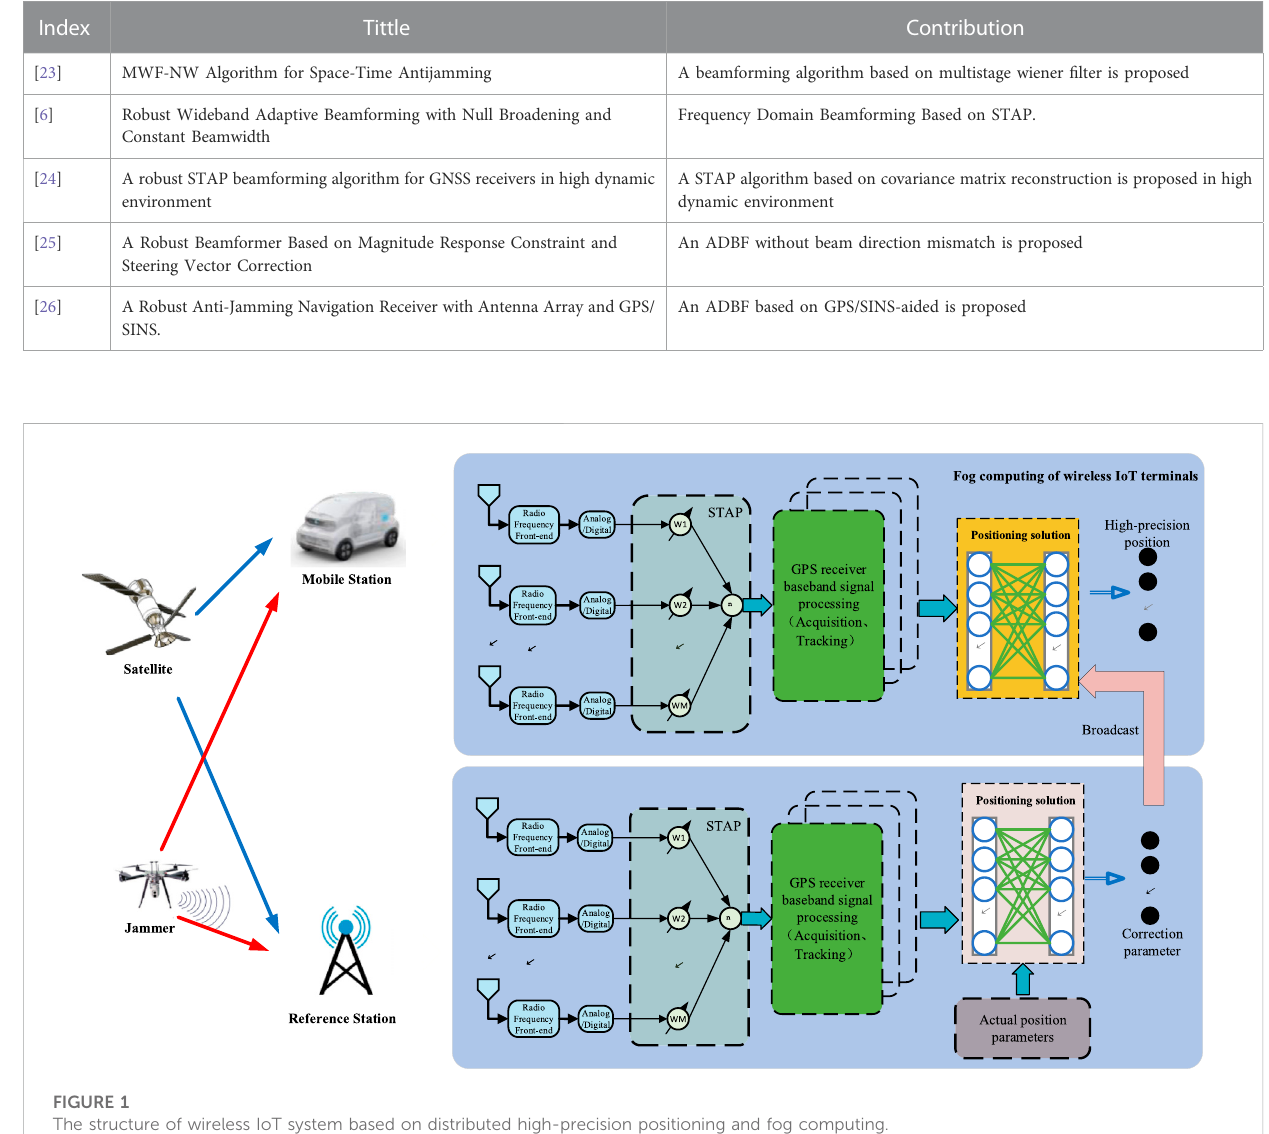
FIGURE 1 The structure of wireless IoT system based on distributed high-precision positioning and fog computing.